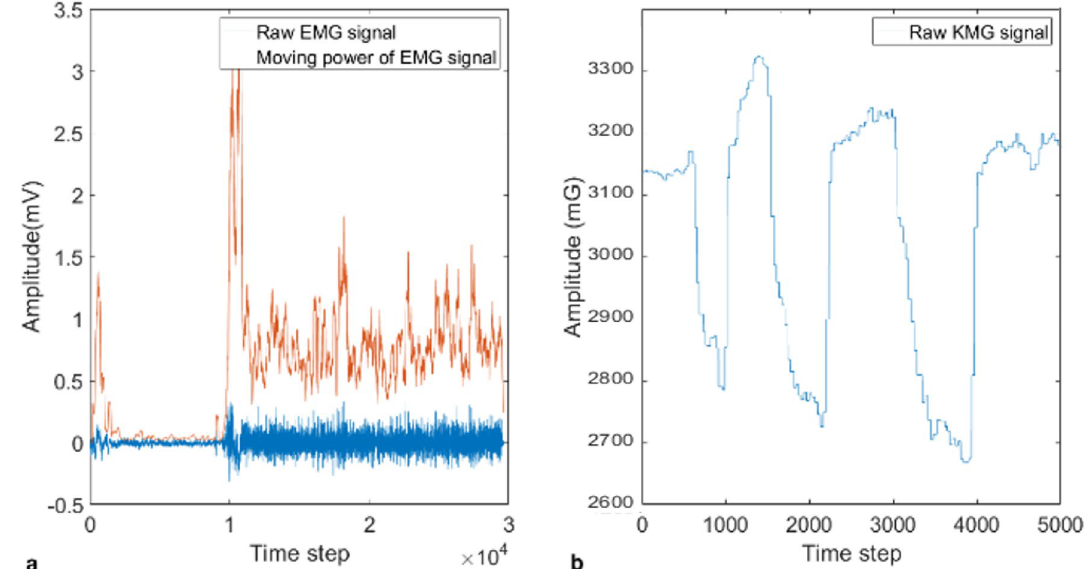
Figure 4. Both data sets are related to the wrist flexion and extension of corresponding muscles. The EMG signal is adopted from 39 related to sensor six adjacent to the extensor Carpi Radialis muscle, subject 4, and fourth test for 10 s at a frequency of 3000 Hz ( a ). The KMG signal is recorded from a sensor close to the wrist magnet implanted in transferred tendons of flexor Carpi Radialis and extensor Carpi Radialis Brevis muscles for 117 s at a frequency of 42.7 Hz ( b